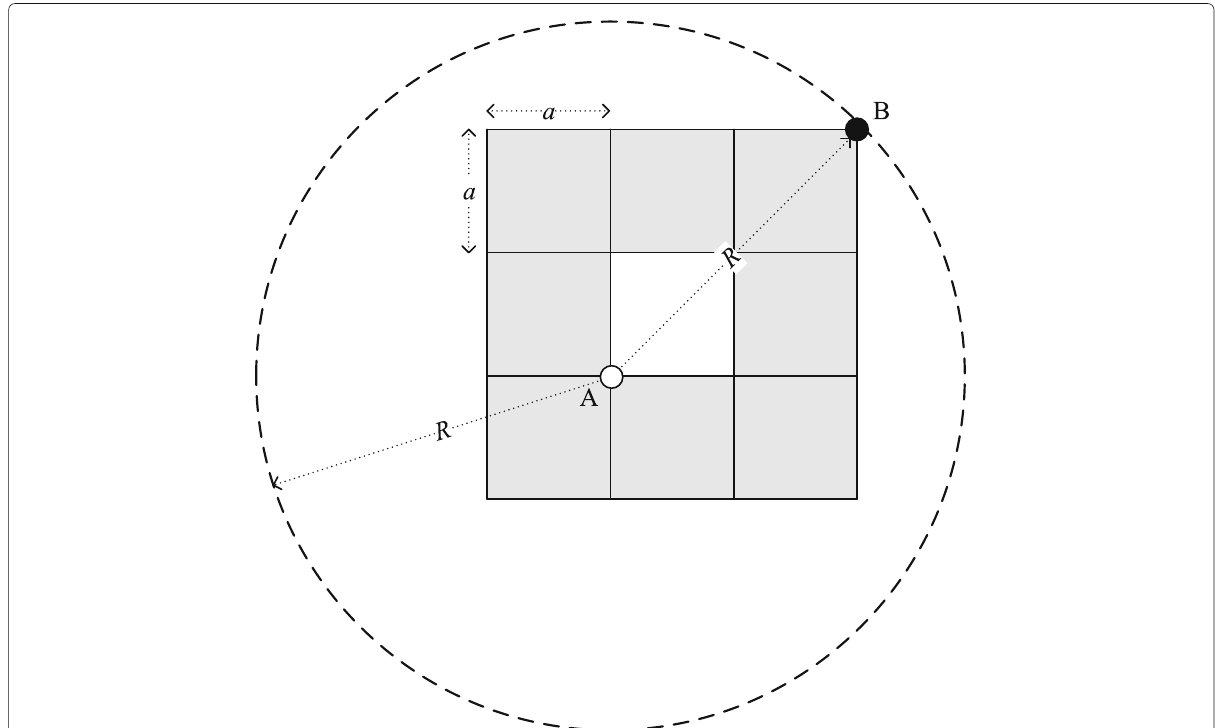
Fig. 2 The relationship between communication radius and a side length of a grid cell. The distance between A and B is R , and it is easy to calculate the value of